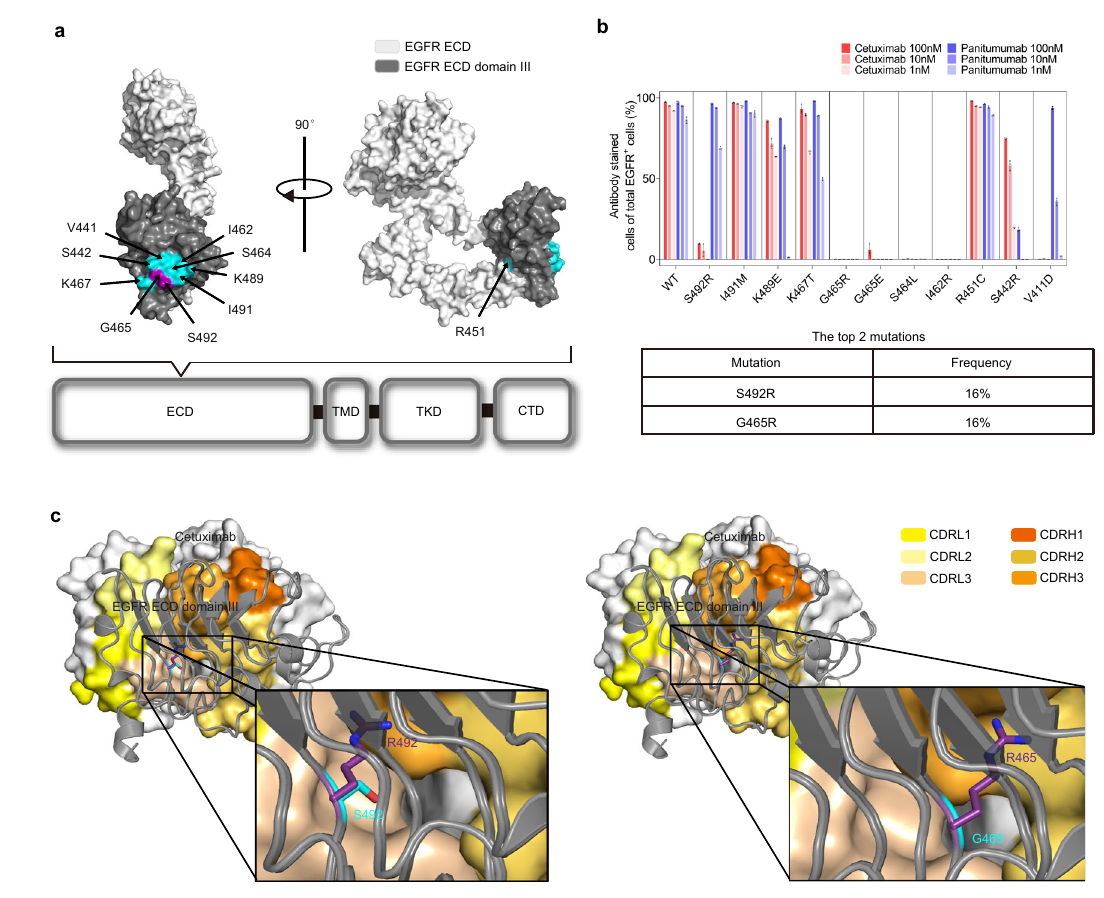
Fig.1|TheimpactofacquiredpointmutationsintheEGFRectodomainonthe bindingabilityofcetuximab.a ThelocationofacquiredpointmutationsinEGFR. The structure of domain III (dark gray) in the EGFR ECD (white) was adapted from the ProteinData Bank (PDBaccession code: 1YY9) and visualizedby PyMOL. Single amino acid mutations that abrogate cetuximab or panitumumab binding are highlighted in cyan, except the S492R and G465R substitutions (purple). b The impact of acquired point mutations in the EGFR ECD on the binding ability of cetuximab and panitumumab (top panel). NIH3T3 cells stably expressing full-